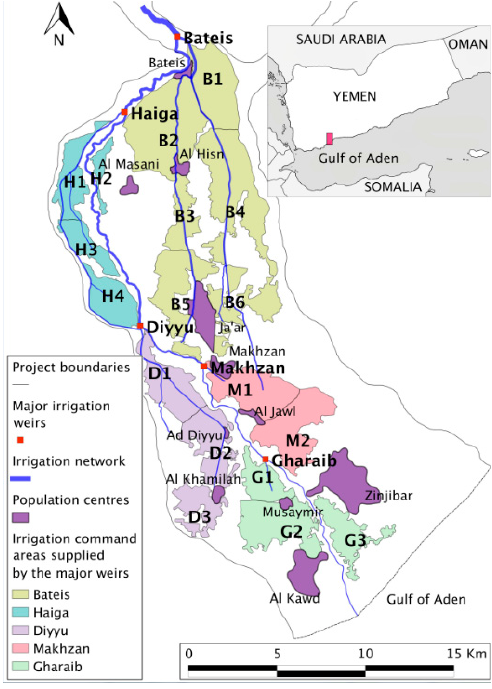
Figure 1. Major irrigation weirs (5), irrigated command areas (18), and population centres of Yemen’s Abyan Delta.